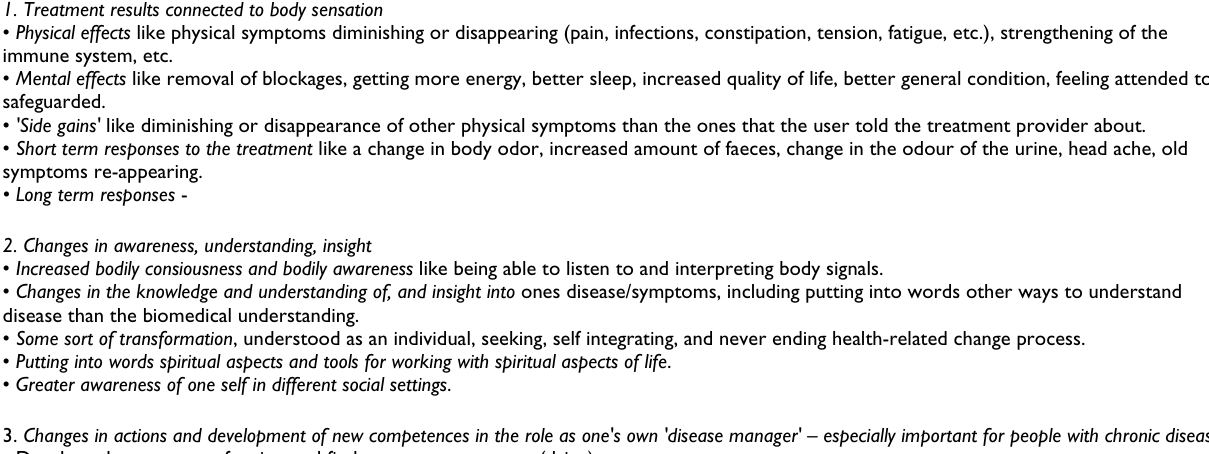
Table 3: Main categories of 'outcomes' of complex interventions